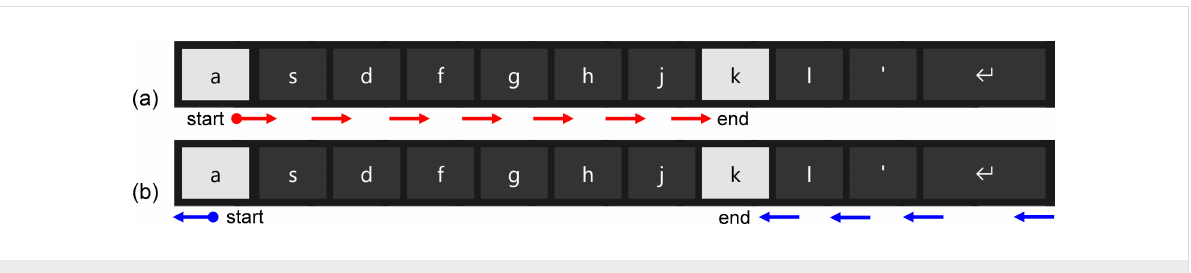
Figure 4: Diagram showing the two possible cursor movement directions to go from letter “A” to “K” in a standard QWERTY keyboard layout; path (a) could be implemented by seven swift left eye movements, and path (b) provides a faster route to reach the same destination by five swift right eye movements.